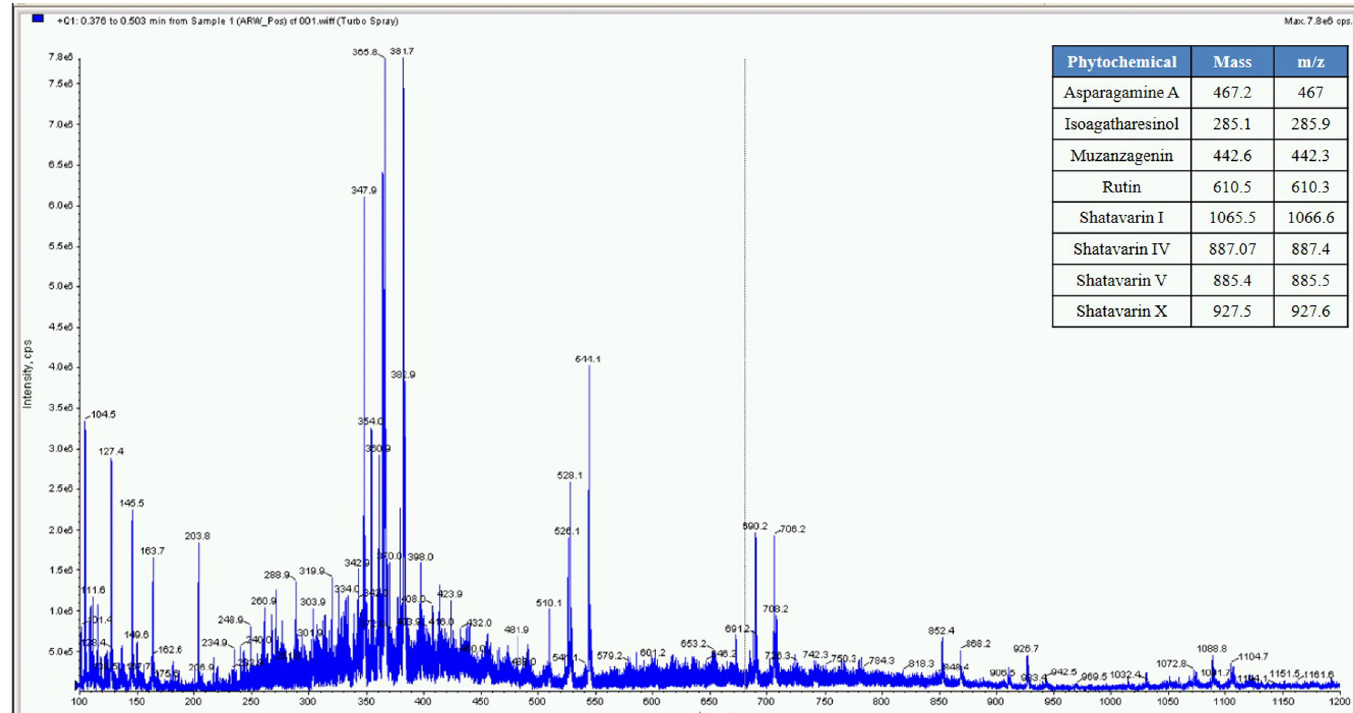
Fig 8. Mass spectrometer fingerprint of Asparagus racemosus water extract (ARW).